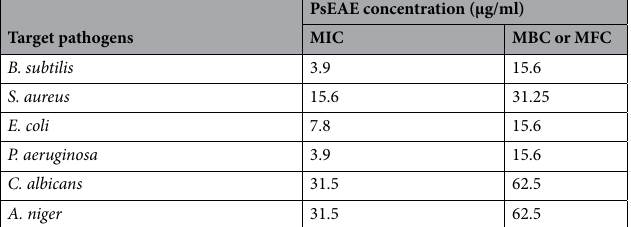
Table 5. Minimum inhibitory (MIC), minimum bactericidal (MBC), and minimum fungicidal concentrations (MFC) of (PsEAE) metabolites from Paecilomyces sp. (AUMC 15510) against different pathogens. PsEAE— ethyl acetate crude extract of Paecilomyces